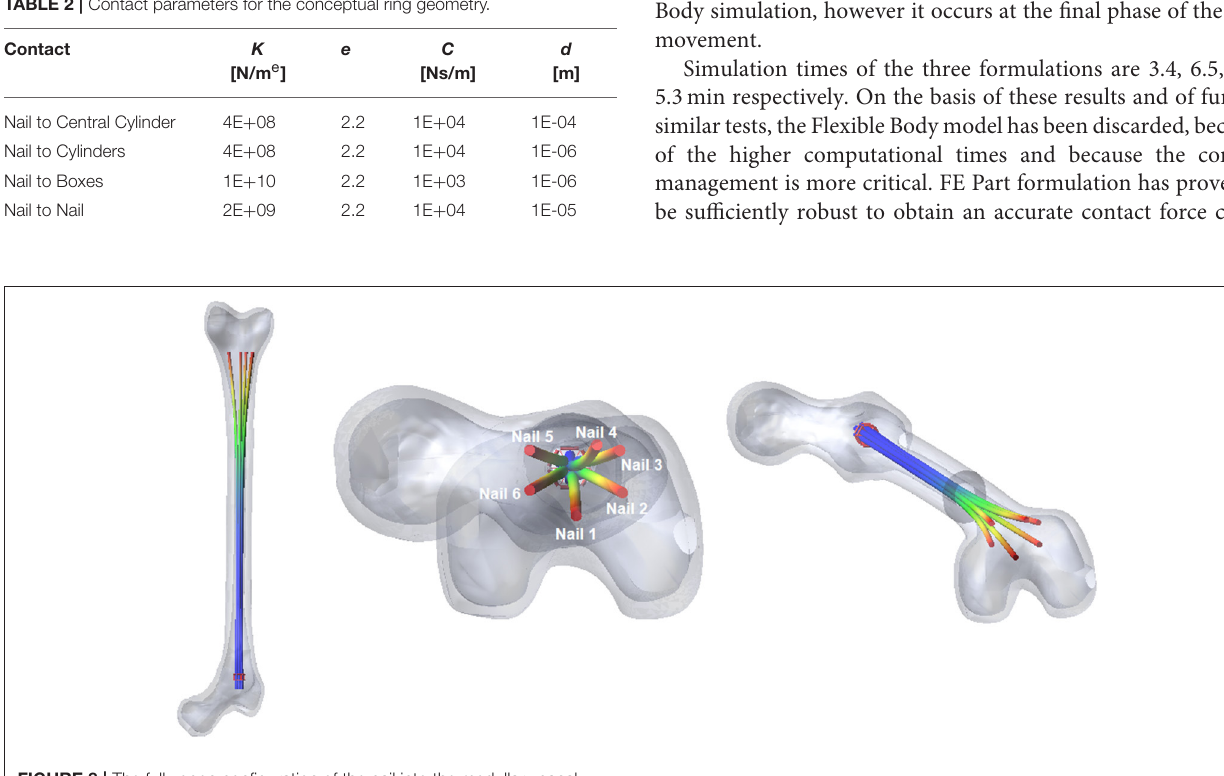
FIGURE 8 | The fully open configuration of the nail into the medullary